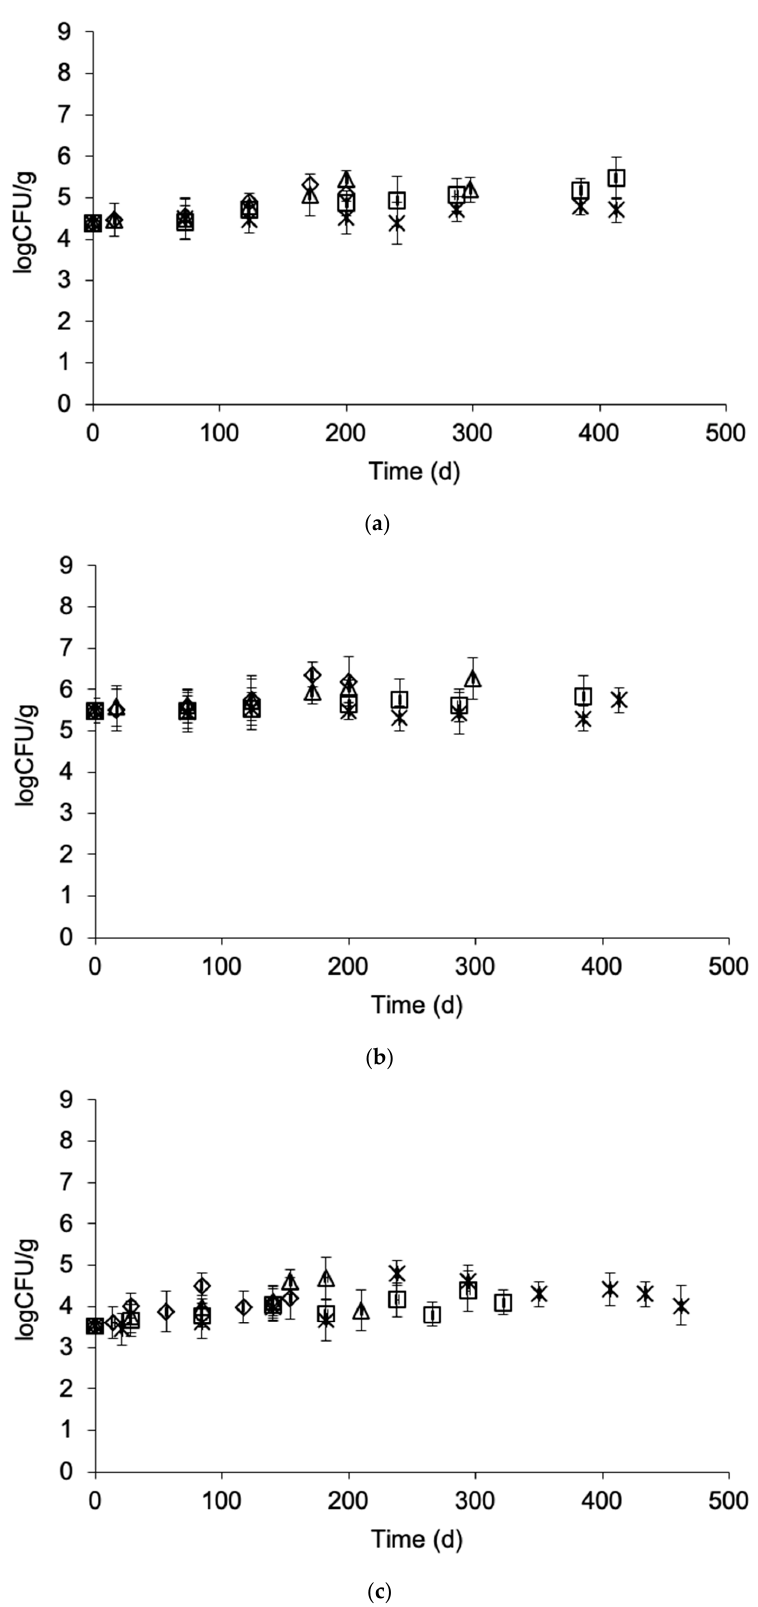
Figure 7. Development of total viable count in ( a ) gilthead sea bream fillets, ( b ) sea bass fillets and ( c ) yellowfin tuna slices during storage at − 5, ∆ − 8, − 12 and ∗ − 15 °C. (Error bars indicate standard error of measurements of two different samples.)